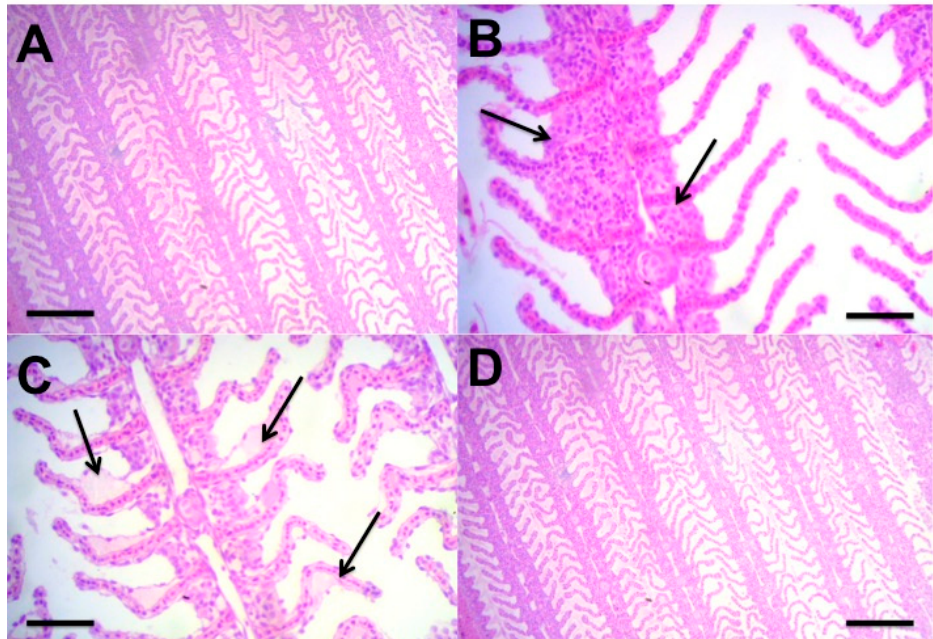
Figure 4. Histology of fish gill structure of the Colossoma macropomum in BFT at the end of phase 2. ( A ) T 6 × 4 and ( D ) T 7 × 6 , normal primary and secondary lamellae; ( B ) T 7 × 4 , moderate hyperplasia; and ( C ) T 6 × 6 , epithelium lifting. ( A ) H–E bar, 200 μ . ( B ) H–E bar, 50 μ . ( C ) H–E bar, 50 μ . ( D ) H–E bar, 200 μ .